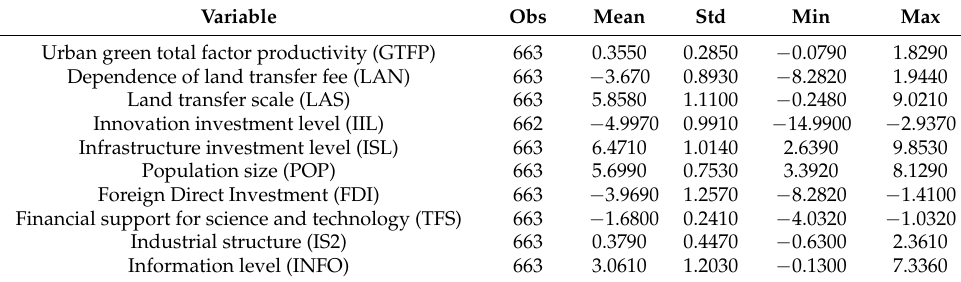
Table 5. Descriptive statistics of main variables (western region